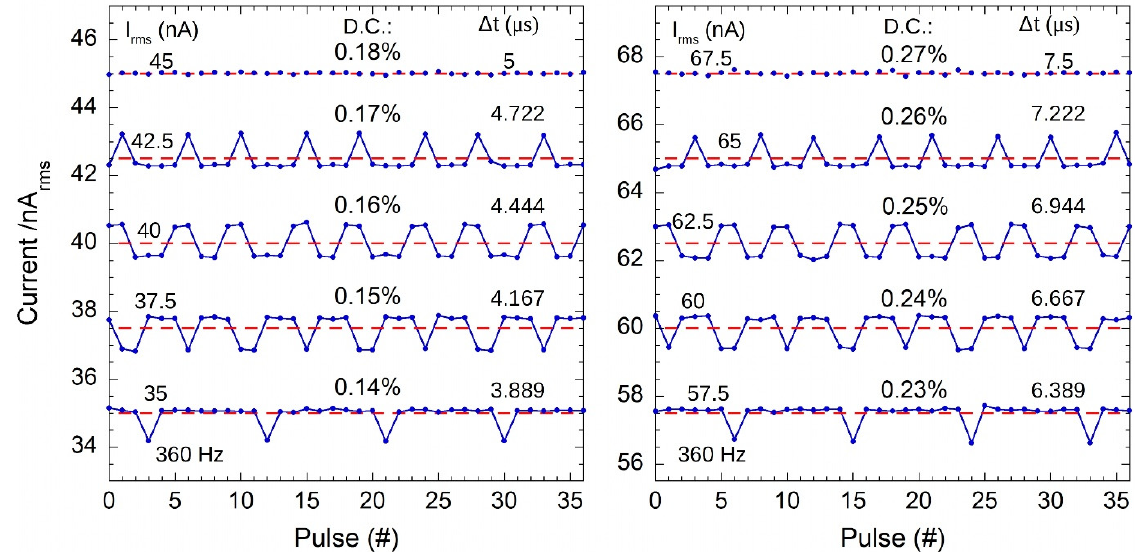
Figure 8. Calculated rms currents at different Δ t values. The I rms mean values are indicated as red dashed lines. dashed